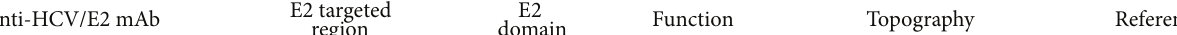
Table 1: Schematic representation of the regions targeted by anti-HCV/E2 mAbs. Involved domains (DI, DII and DIII as well as the stem region) of HCV/E2 have been evidenced. In particular, DI has been described to be a discontinuous region containing the CD81 binding site; DII is predicted to possess the fusion peptide and DIII has been recently described to contain antigenic neutralization epitopes and to be involved in heterodimerization with